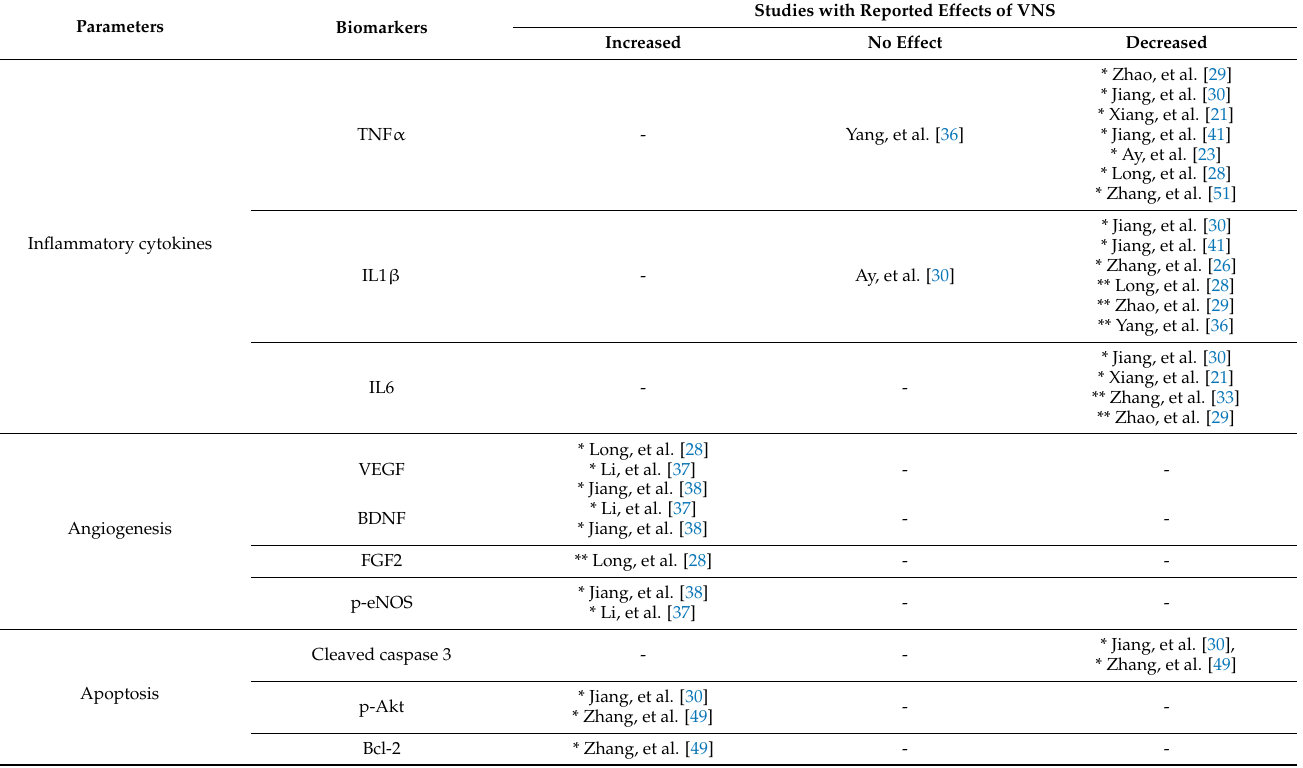
Table 3. Summary of biomarker